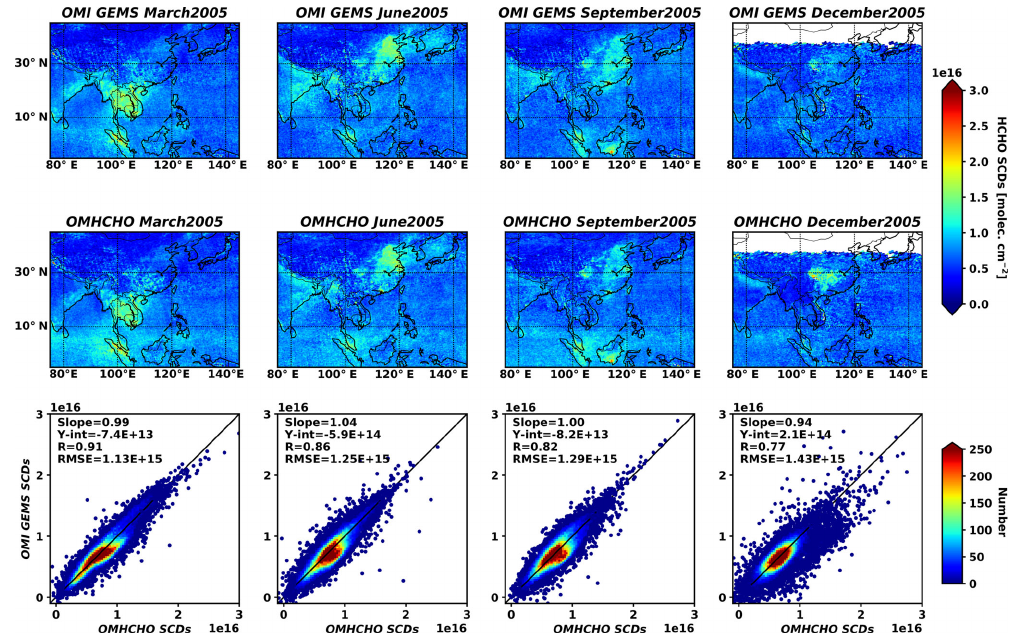
Figure 8. Monthly mean slant column densities (SCDs) from the GEMS algorithm (first row) and OMHCHO products (second row) for 4 months in 2005, and scatter plots between GEMS and OMHCHO. Statistics are given in the figures. Table 3. Relative differences between OMI GEMS HCHO slant columns and OMHCHO and OMI QA4ECV slant columns in four regions. Region GEMS vs. OMHCHO GEMS vs. OMI